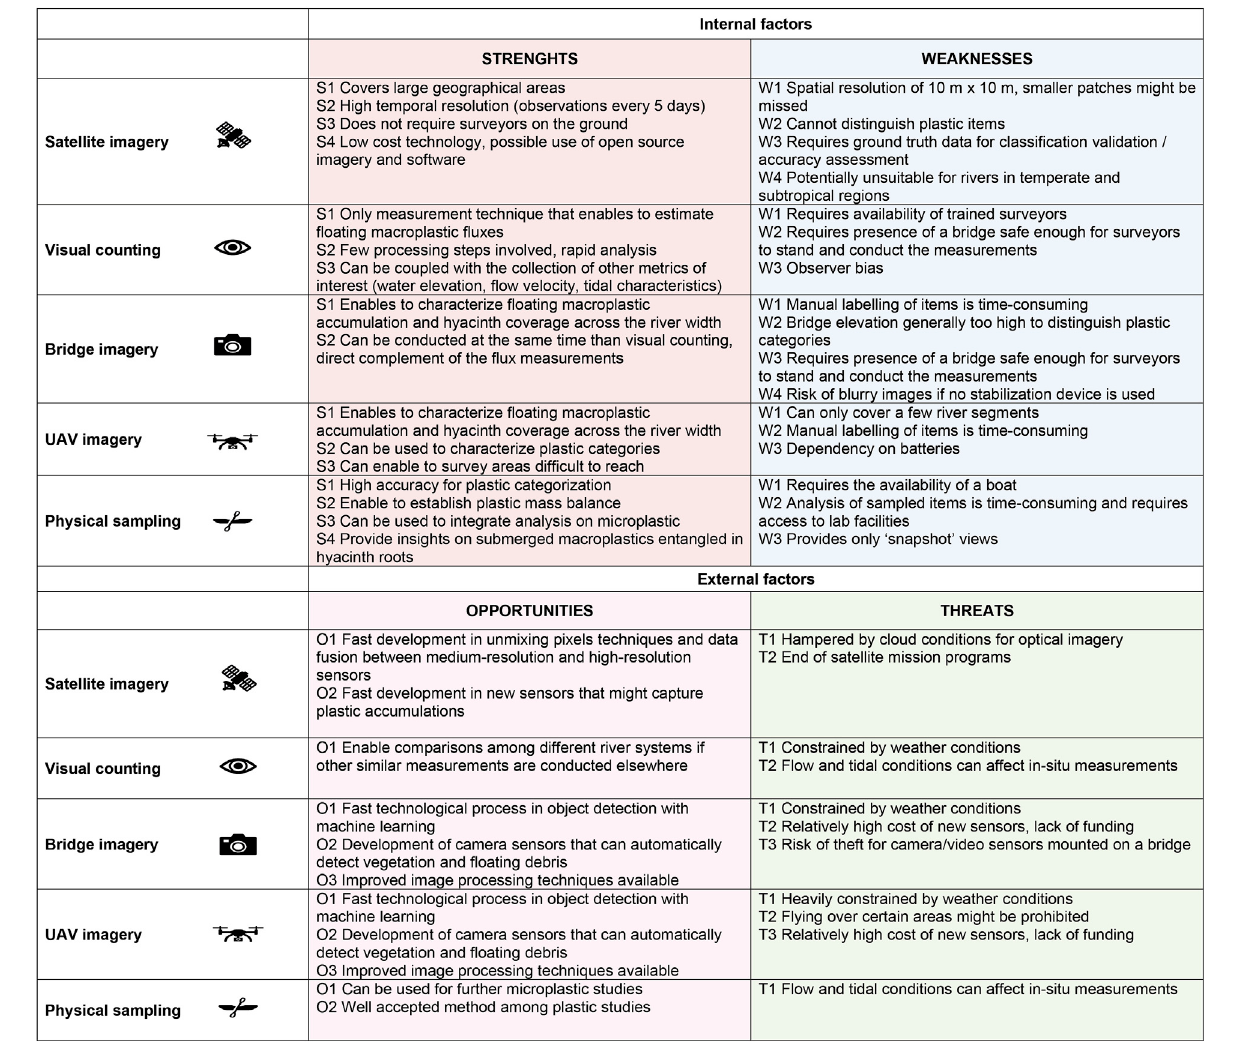
FIGURE 13 | SWOT analysis for each measuring technique